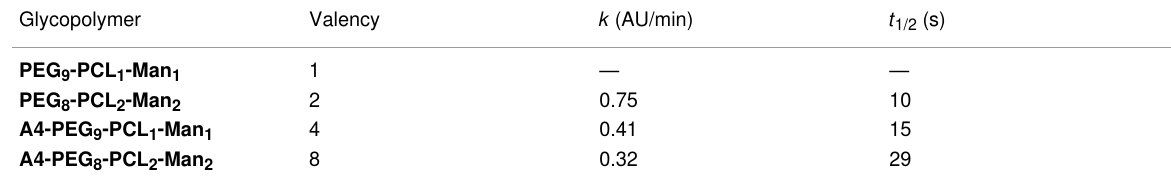
Table 3: Initial rates of Con A precipitation ( k , AU/min) and time to reach half of the maximum turbidity ( t 1/2 , s) in turbidity assays. Glycopolymer Valency k (AU/min) t 1/2 (s) —